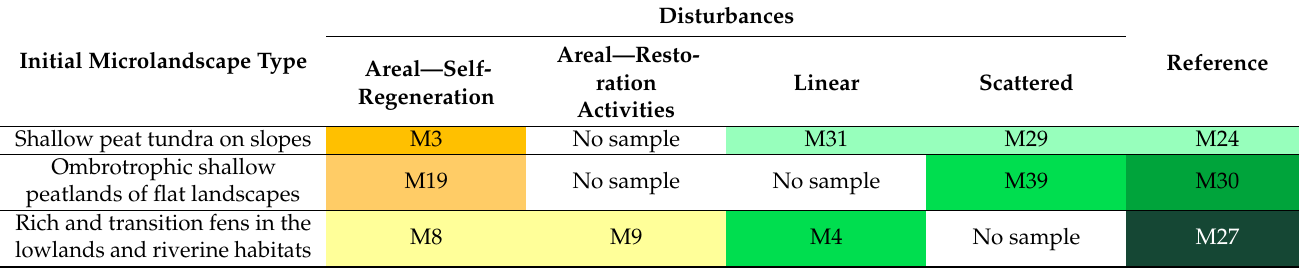
Table 6. Matrix of habitats describing disturbance types along the initial landscape types. Abbrevia- tions: green cells indicate less disturbed objects, yellow—more disturbed. The intensity of the color reflects the degree of severity of the property along the